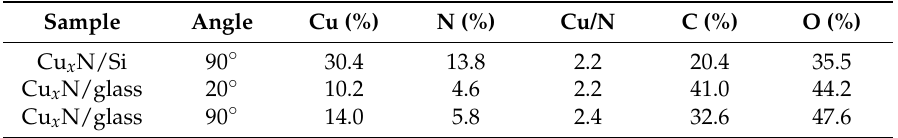
Figure 7. X-ray photoelectron spectroscopy (XPS) spectra of deposited Cu x N films (detection angle 90°). ( a ) Cu-2 p (Si substrate); ( b ) Cu-2 p (glass substrate); ( c ) N-1 s (Si substrate); ( d ) C-1 s (Si substrate); ( e ) O-1 s (Si substrate). Table 2. Relative surface composition of deposited Cu x N films as derived from XPS analysis.